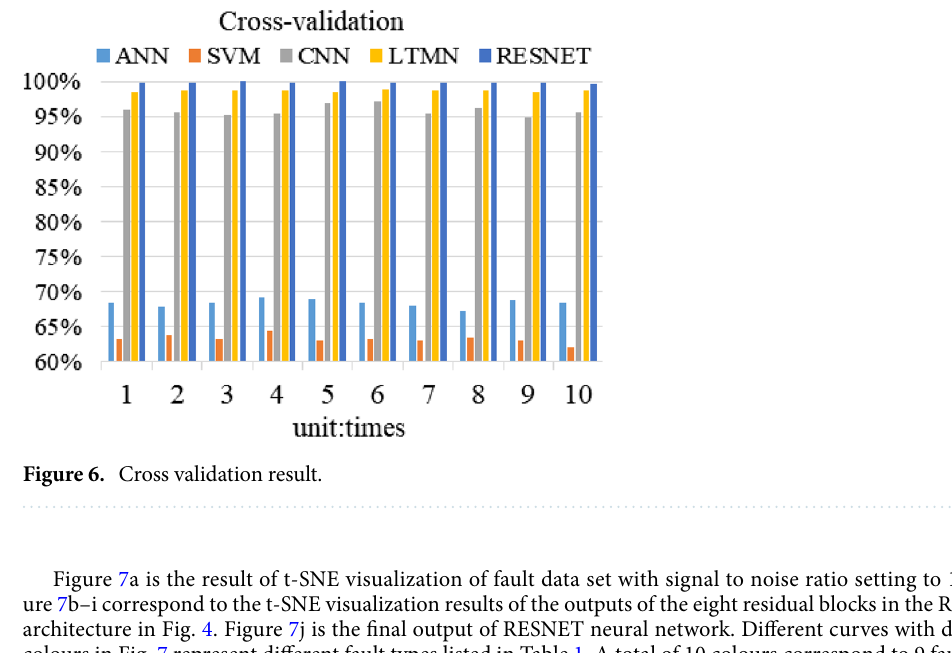
Figure 7a is the result of t-SNE visualization of fault data set with signal to noise ratio setting to 10. Fig- ure 7b–i correspond to the t-SNE visualization results of the outputs of the eight residual blocks in the RESNET architecture in Fig. 4. Figure 7j is the final output of RESNET neural network. Different curves with different colours in Fig. 7 represent different fault types listed in Table 1. A total of 10 colours correspond to 9 faults and 1 health state for robot joint system. It can be seen from the Fig. 7 that with the increase of residual blocks, the data expression ability of RESNET